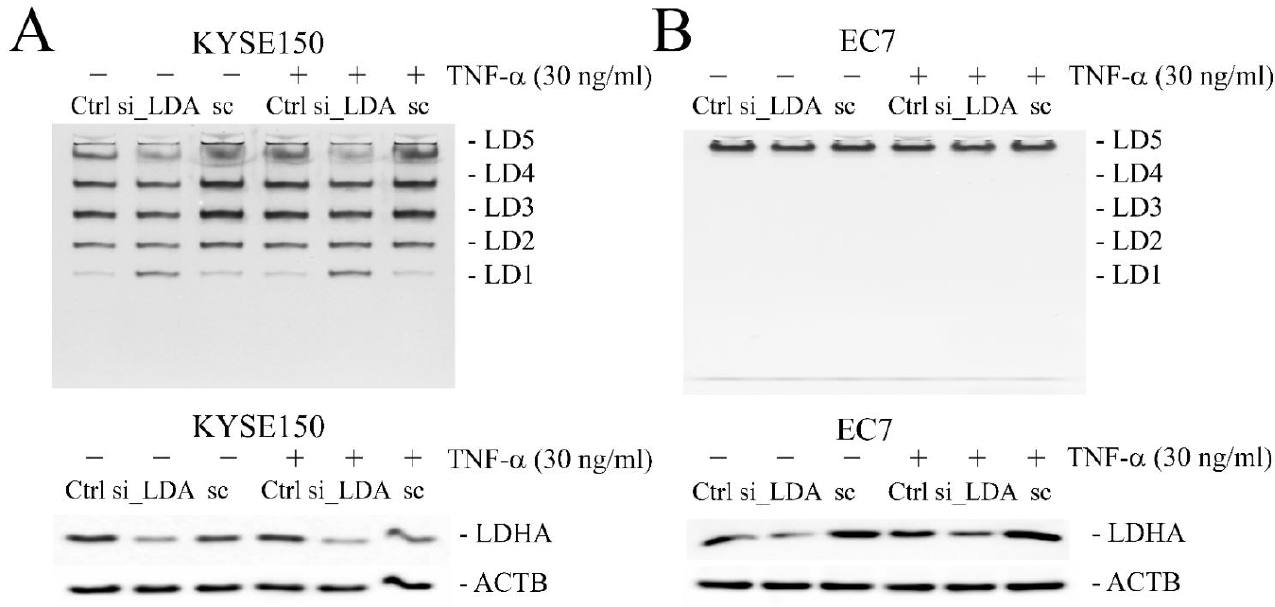
Figure 6. The effect of LDHA gene silencing on the composition of LDH isoforms and on the protein level of LDHA in esophageal cancer cells. ( A ) A shift in the percentage of LDH isoforms toward forms with an increased proportion of the B subunit, observed in KYSE150 cells transfected with LDHA siRNA by zymography (upper panel). Downregulation of LDHA protein in KYSE150 cells due to silencing of LDHA gene expression (SE: 38 ± 1.5%) visualized by Western blotting (bottom panel). ( B ) Reduced levels of LD5 isoform, as seen on zymogram (upper panel), and LDHA protein, as observed by Western blotting (bottom panel), as a result of silencing of LDHA gene expression (SE: 55.7 ± 13%) in EC7 cells. Ctrl — control; si_LDA — LDHA siRNA; sc — scrambled sequence siRNA; ACTB — β -actin/loading control; SE — gene silencing efficiency vs. control levels.